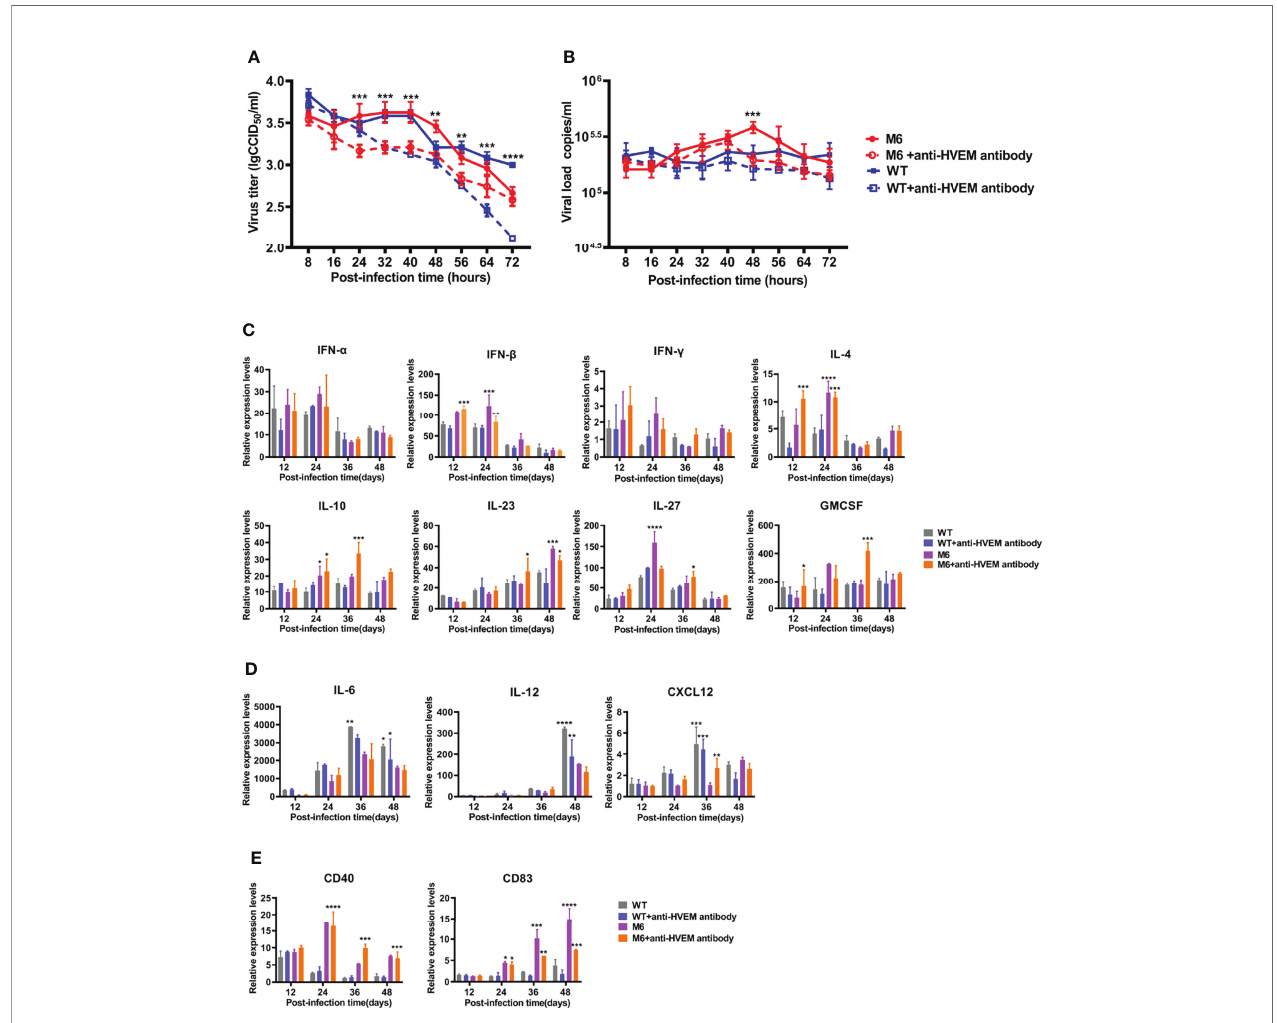
FIGURE 2 | The dynamic processes in JAWS II-dendritic cells infected with the wild-type strain and attenuated M6 strain. The replication (A) and viral load (B) of JASWII- dendritic cells infected with the wild-type strain (solid blue square and hollow square) and attenuated M6 strain (solid red circle and hollow circle). The M6+anti-HVEM antibody group is compared with the M6 group, and the WT+anti-HVEM antibody group is compared with the WT group. Transcriptional pro fi le analysis of immune regulators and effectors (C, D) in JASWII-dendritic cells infected with the wild-type strain (gray and blue) and attenuated M6 strain (purple and orange). The relative expression levels of in fl ammatory cytokines in JAWS II dendritic cells were normalized to their levels in the blank control group (without viral infection and antibody) using the comparative Ct ( DD Ct) method. The data are shown as the mean ± SEM based on data from three independent experiments. * P < 0.05, ** P < 0.01, *** P < 0.001, **** P <